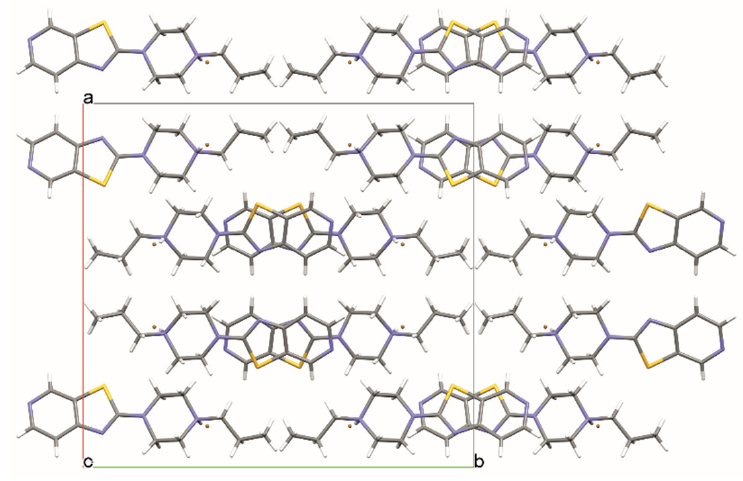
Figure 12. The intermolecular hydrogen bonds in compound 4 .